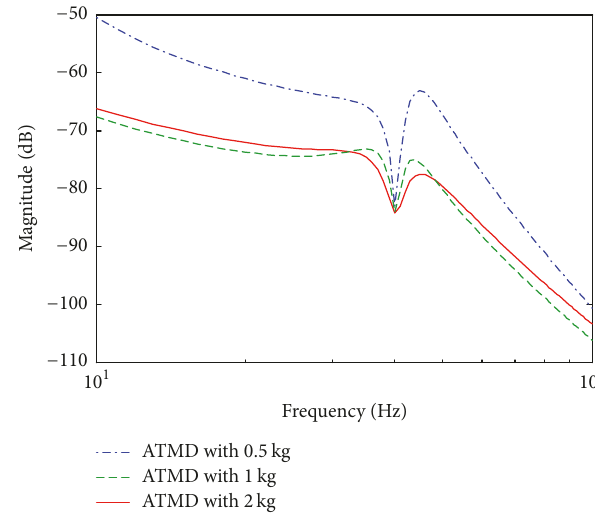
Figure 11: The power of the ATMDs with different